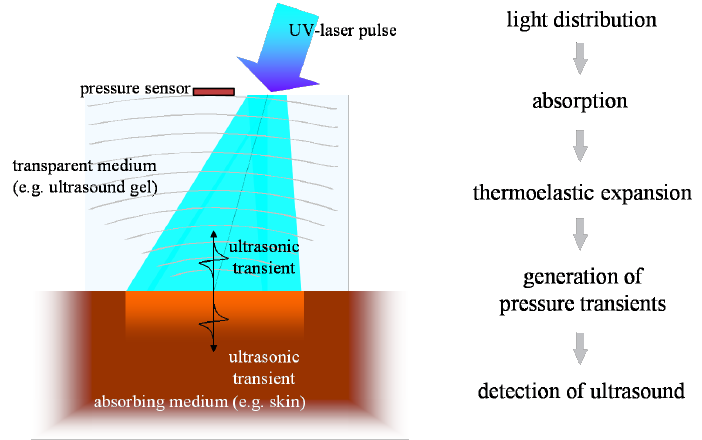
Figure 16. Principle of optoacoustics: the process of thermo-optical excitation of ultrasound (reproduced with permission from